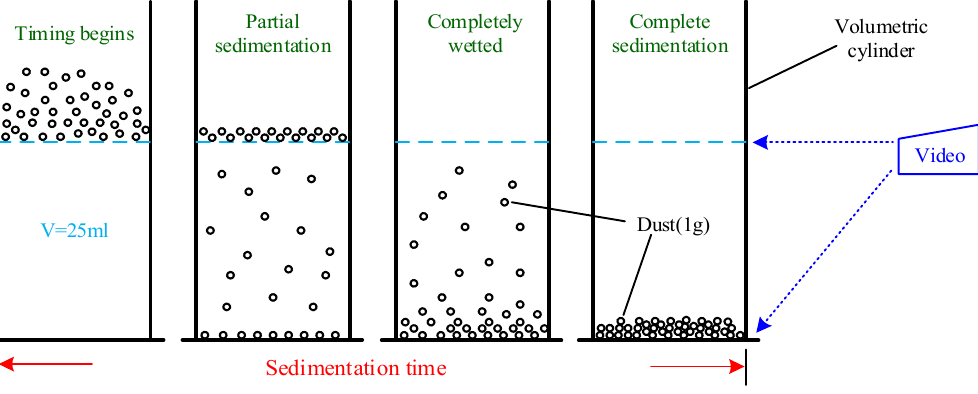
Figure 2. Schematic diagram of sedimentation wetting time experiment. 2. Evaporation stabilization time: (a) Dry 50-g test dust samples are stacked in a φ 100-mm glass petri dish, showing a natural accumulation. (b) A total of 10 mL of the test solution is uniformly dropped with 3% mass concentration on the surface of the test dust reactor. The initial mass is recorded after 10 min. (c) The test dust sample is placed in a drying oven (50 °C, windless), and the dust mass is weighed and recorded every 10 min until the mass change rate is less than 0.1%. The evaporation stabilization time is recorded. Figure 3 is the schematic diagram of the stabilization experiment.